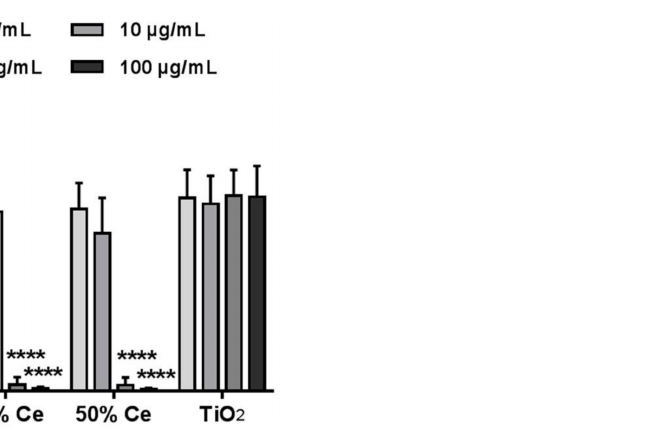
Figure 5. WST-1 assay of RAW 264.7 macrophages exposed to Gd 2(1 − x ) Ce 2 x O 2 S and TiO 2 P25 nanoparticles at different concentrations during 24 h. The mitochondrial activities were reported as percentages of that of unexposed cells. The experiments were repeated at least three times. **** signifies a p -value inferior to 0.0001.